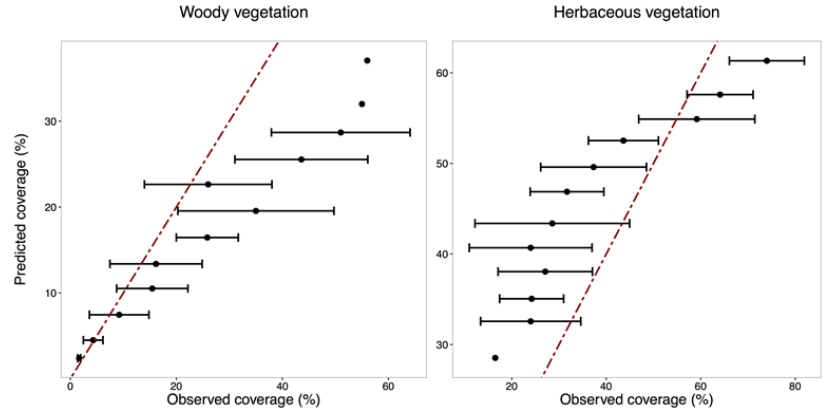
Figure 6. Comparison between field measurements and model estimations. The horizontal bars represent standard errors for field surveys within coverage bins.